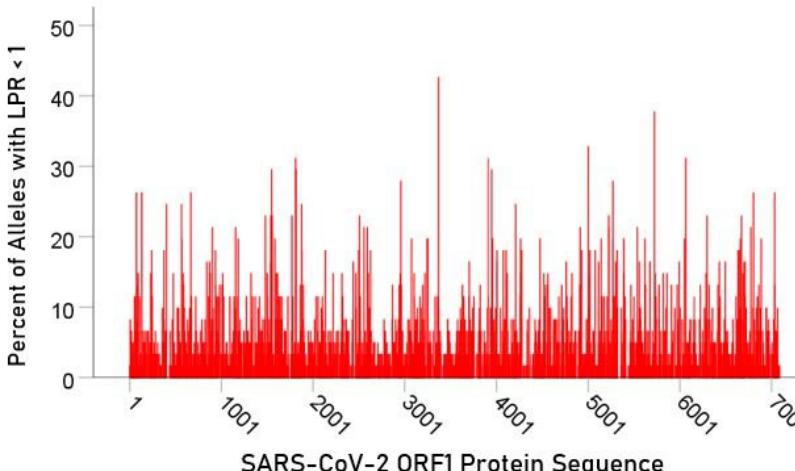
Figure 6. Distribution of alleles with LPR < 1 for an epitope along the S protein